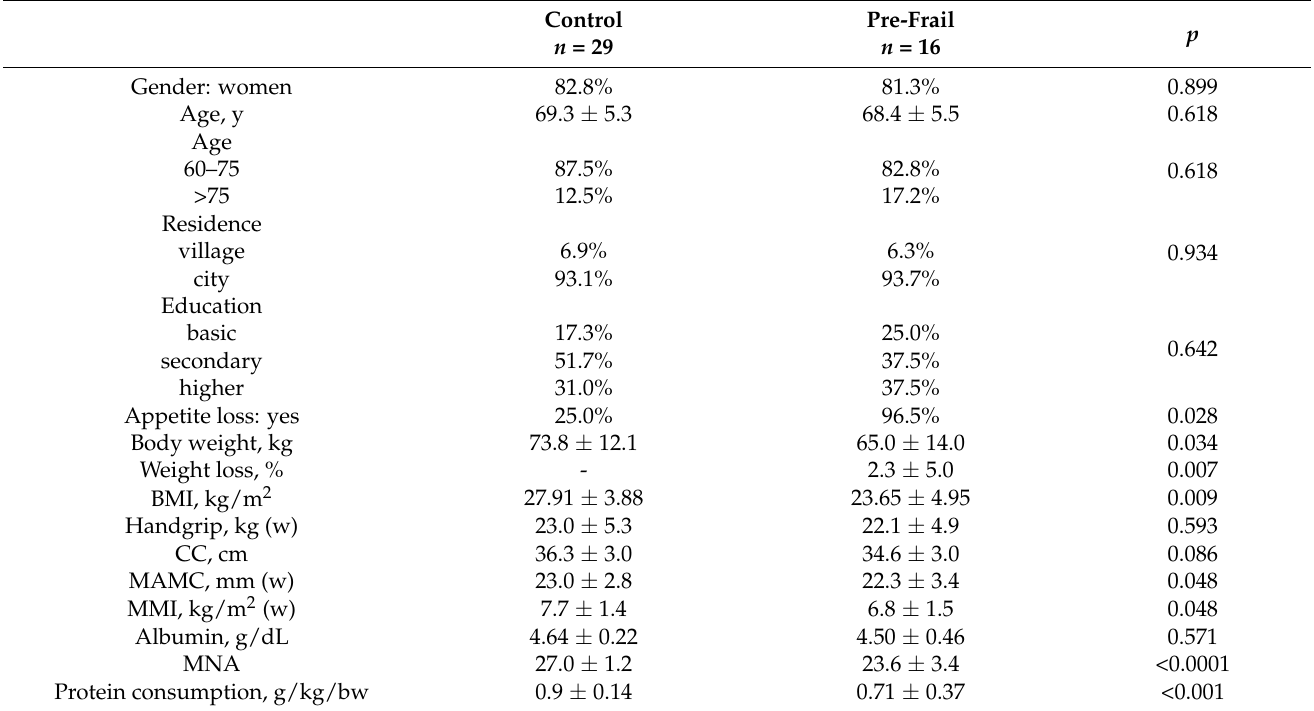
Table 1. Basic characteristics of study participants.